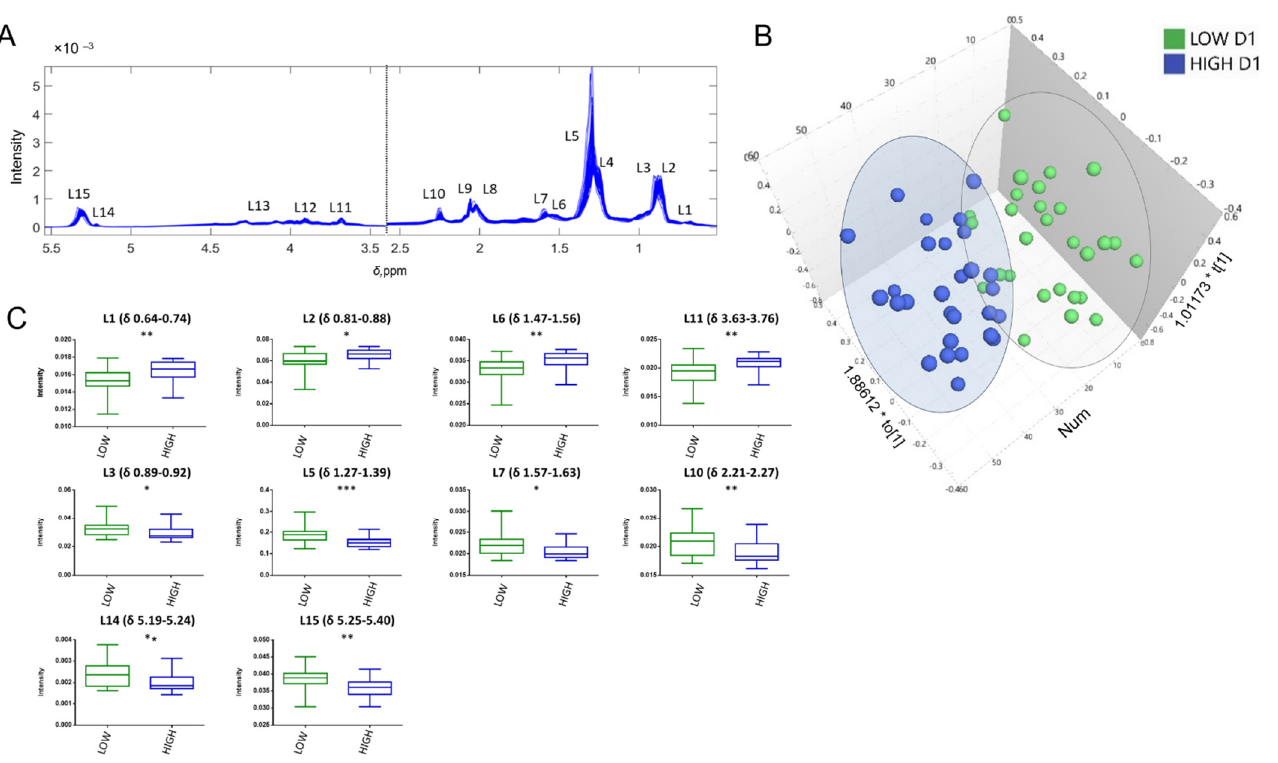
Figure 4. Analysis of longitudinal encode-decode (LED) spectra. ( A ) LED NMR spectra ( n = 58) with assignment. ( B ) Scores plots obtained from the OPLS-DA of high vs. low responders at Day 1 after first dose. The two groups are discriminated into ( • ) Low responders at Day 1 and ( • ) High responders at Day 1. ( C ) Boxplots of the statistically significant lipids. The p -value of t -test is indicated on the top. Lipids numbering is according to Table S5. Asterisks indicate statistical significance: *** 0.0001 < p < 0.001, ** 0.001 < p < 0.01, * 0.01 < p < 0.05.